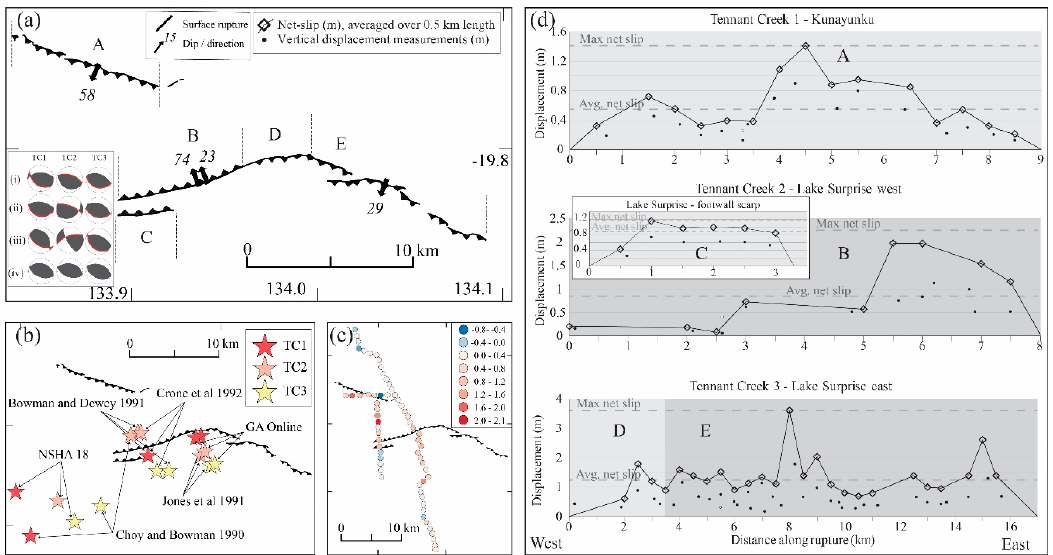
Figure 7. 1988 Mw 6.3 (TC1), 6.4 (TC2) and 6.6 (TC3) Tennant Creek earthquakes ( a ) rupture and cracking map of Kunayungku and Lake Surprise scarps with available dip measurements also the locations of trenches from [63] with faults labelled as per displacement graphs, focal mechanisms (red line shows preferred plane from original publication) from (i) McCaffrey 1989, (ii) Choy and Bowman 1990, (iii) Jones et al. 1991, (iv) CMT, ( b ) published epicenter locations of all three mainshocks ( c ) resurveyed benchmark offsets [63] uncertainties as discussed in text, and ( d ) graphs of along-rupture vertical and lateral displacement measurements [63] and net slip calculated from available data averaged over 0.5 km increments (this study).